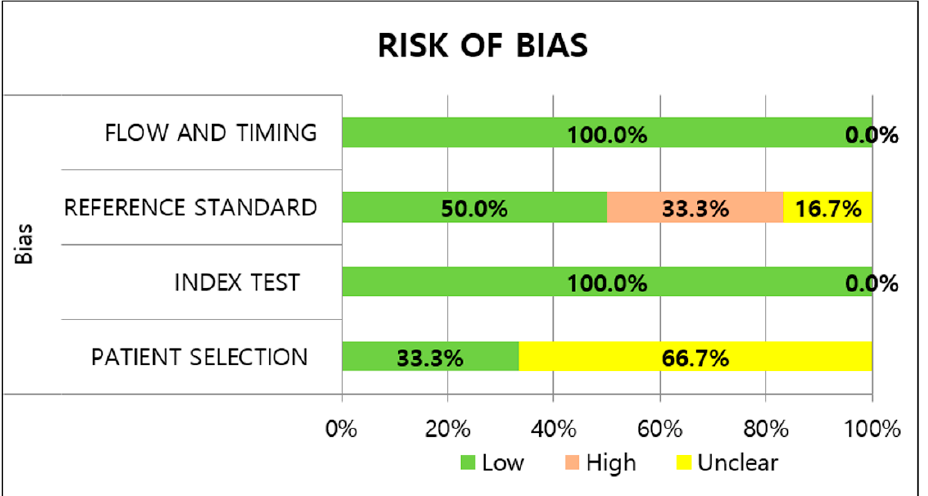
Figure 2. Methodological quality of included studies for risk of bias.